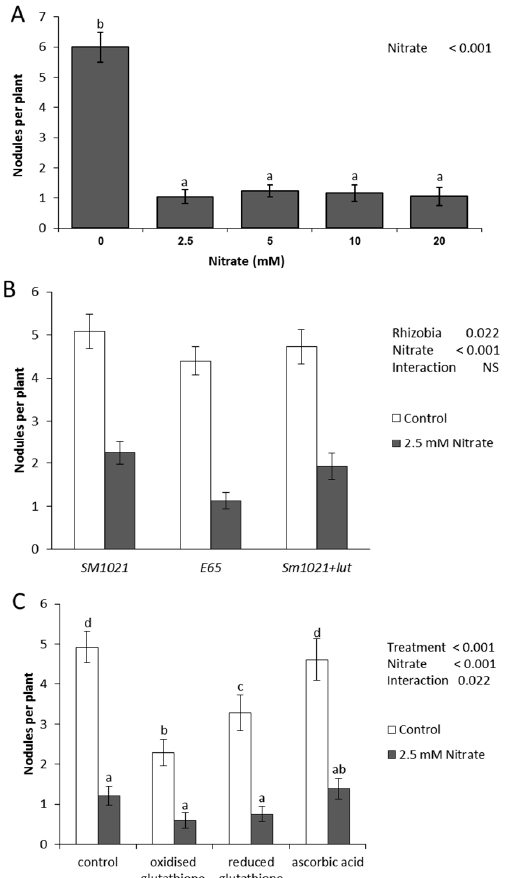
Figure 1. Reduction of nodule numbers in M. trunatula in response to nitrate. ( A ) Nodule number responses to varying concentrations of nitrate. The histograms show means of nodule numbers per plant on plates containing the indicated levels of nitrate, three weeks p.i. (post inoculation) with S. meliloti ( n = 21). Error bars represent standard error. Bars marked with different lower case letters show statistically significant differences ( p < 0.001, one-way ANOVA); ( B ) Nodule number responses to different rhizobia. Plants were nodulated in the absence and presence of 2.5 mM nitrate with either the wild type S. meliloti strain ( SM1021 ), an S. meliloti strain with constitutive nodD2 expression ( E65 ) or the S. meliloti strain 1021 grown in the presence of the Nod gene inducer luteolin ( Sm1021+lut ). The histograms show means of nodule numbers per plant on plates three weeks p.i. ( n = 25). Error bars represent standard error. Nitrate ( p < 0.001) and strains ( p = 0.022) had a significant effect on nodule numbers (two-way ANOVA); ( C ) Nodule number responses to changes in the redox state. The histograms show means of nodule numbers per plant on plates containing 0 or 2.5 mM of nitrate and 100 µM of either oxidized glutathione, reduced glutathione or ascorbic acid, three weeks p.i. with S. meliloti ( n = 19–26). Error bars represent standard error. Nitrate ( p < 0.001) and treatments ( p < 0.001) had a significant effect on nodule numbers, and there was a significant interaction between both at p = 0.022 (two-way ANOVA). Bars marked with different lower case letters show statistically significant differences.